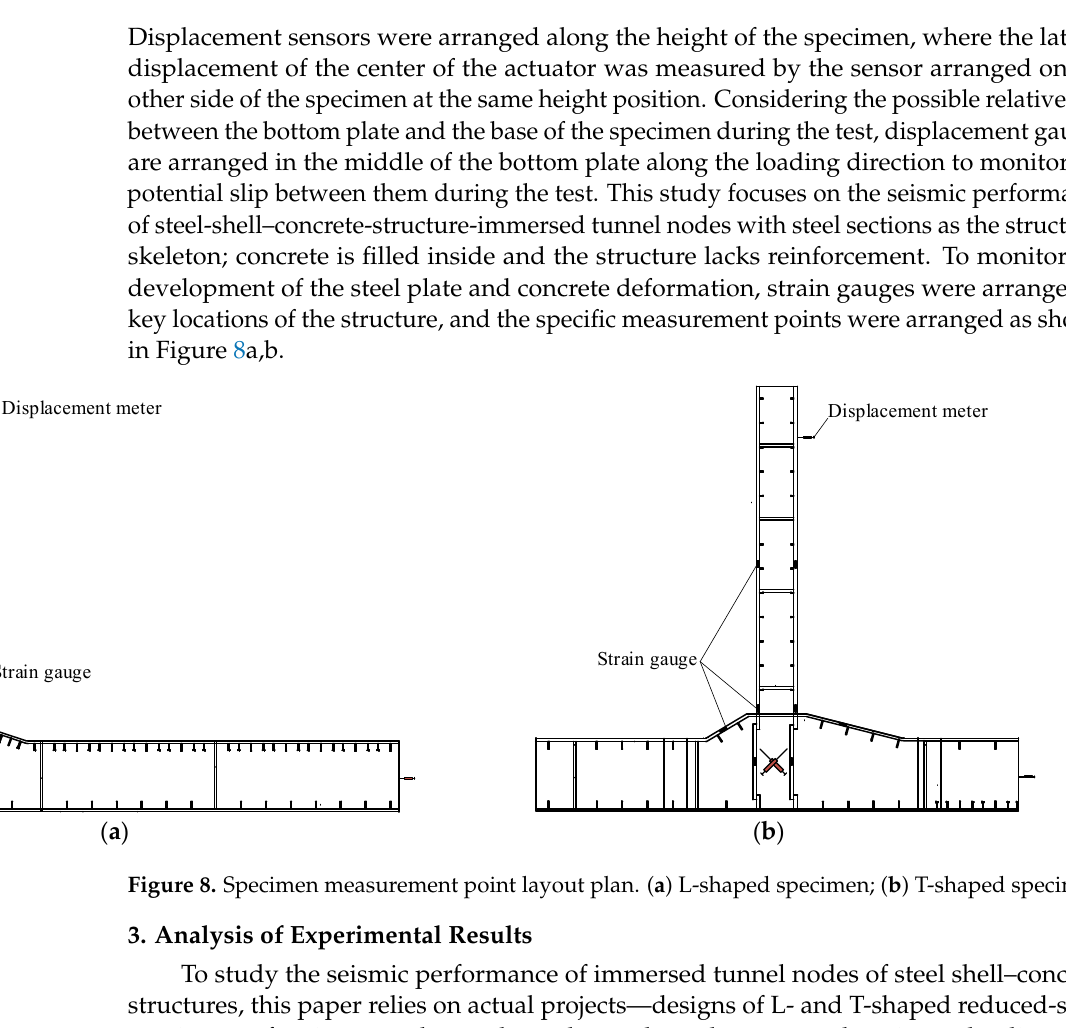
Figure 7. Specimen loading system. ( a ) L-shaped specimen; ( b ) T-shaped specimen.